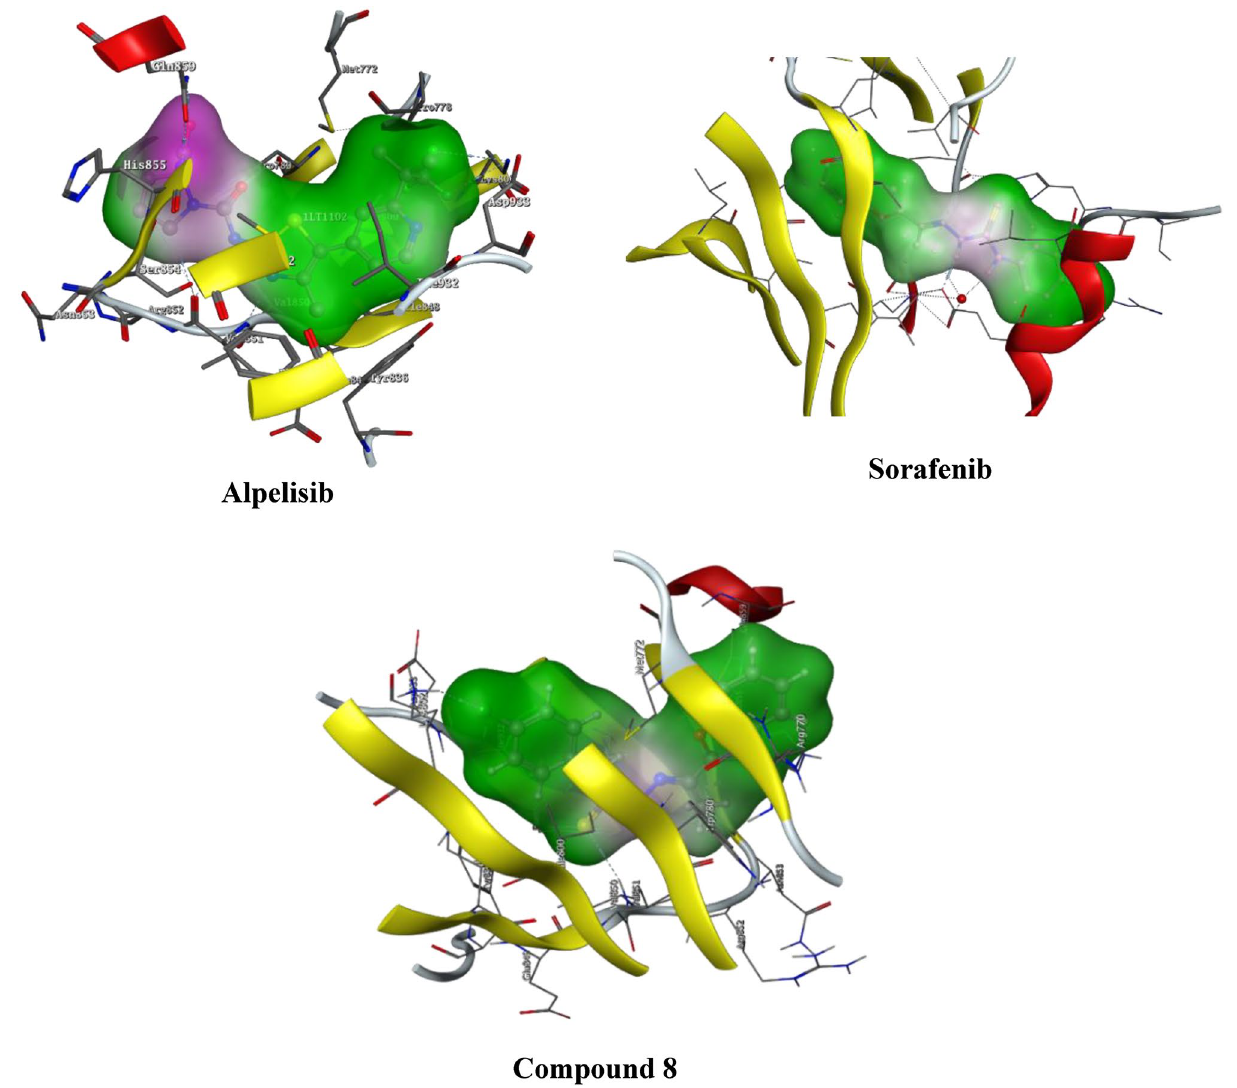
Figure 9. 3D surface map for alpelisib, sorafenib and compound 8 . Pink: hydrophilic, white: neutral, green